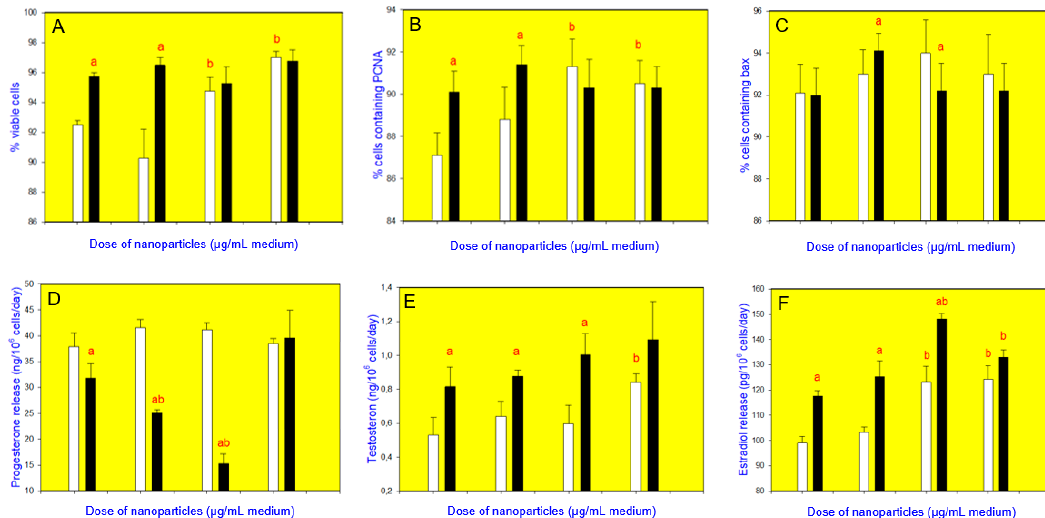
Figure 6. Effect of CuNPs/TiO 2 (0, 1, 10, or 100 µg/mL) alone (white bars) and in combination with apigenin (10 µg/mL; black bars) on the viability (Trypan blue exclusion assays) ( A ), proliferation (expression of proliferating cell nuclear antigen, PCNA, quantitative immunocytochemistry) ( B ), apoptosis (expression of bax, quantitative immunocytochemistry) ( C ), and secretion of progesterone (enzyme-linked immunosorbent assay, ELISA) ( D ), testosterone (ELISA) ( E ), and 17 β -estradiol (ELISA) ( F ) in cultured porcine ovarian granulosa cells. The values are expressed as the mean ± SEM; a: effect of apigenin-significant ( p < 0.05) differences between the corresponding groups of cells, treated and untreated with apigenin and b: effect of CuNPs/TiO 2 -significant ( p < 0.05) differences between the cells, treated and untreated with CuNPs/TiO 2 .